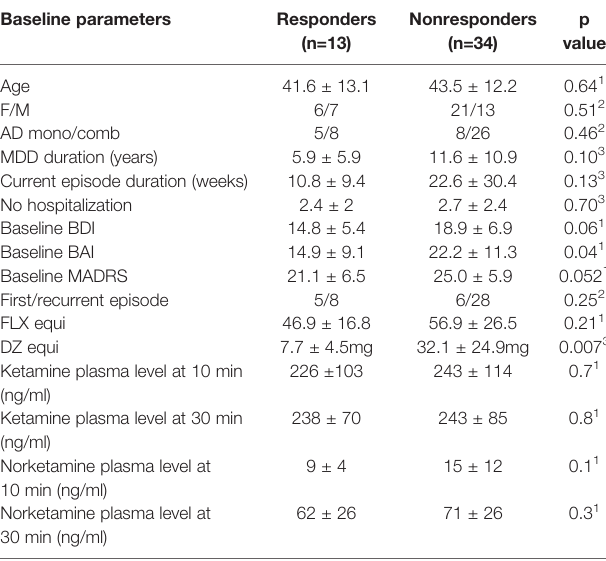
TABLE 1 | Baseline characteristics of responders vs. nonresponders.